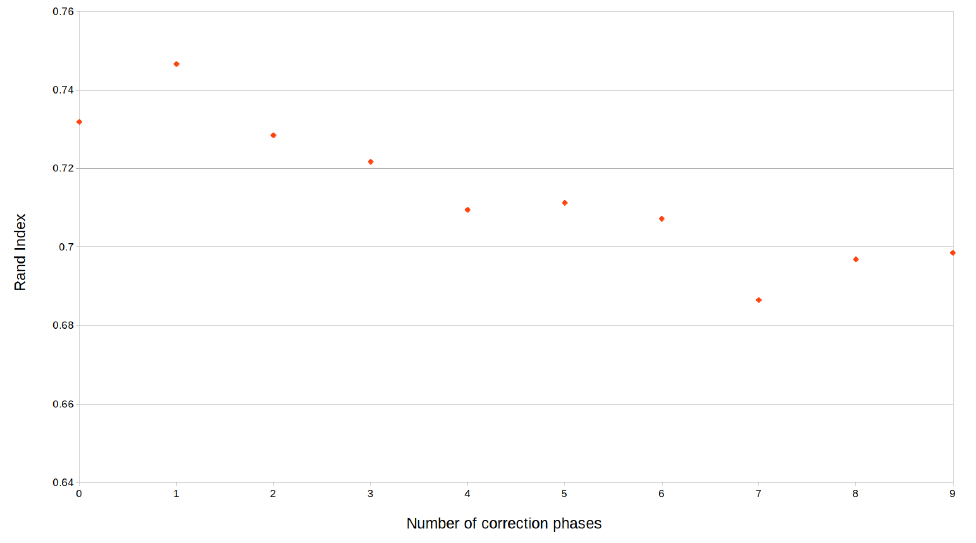
Figure 3. The impact of the number of correction runs CR on the performance of the algoritm for anuran calls dataset measured by Rand